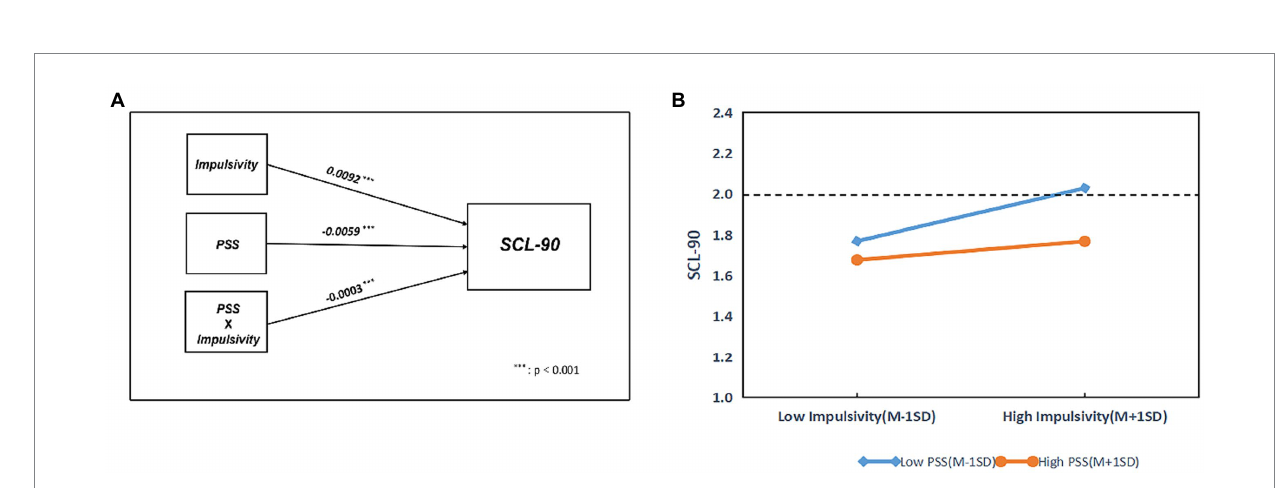
FIGURE 3 The effect of impulsivity on SCL-90 moderated by PSS. PSS, Perceived Social Support. r: Pearson correlation coefficient; p: p -value.